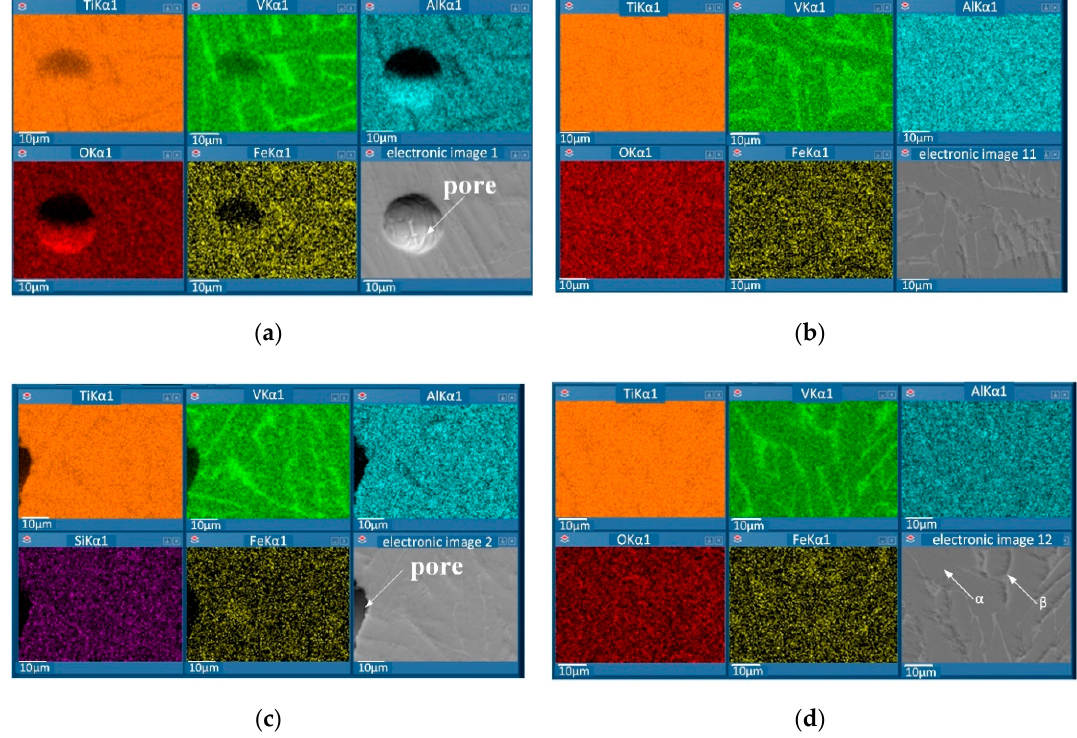
Figure 9. Energy-dispersive X-ray spectroscopy (EDS) mapping of the Ti-6Al-4V alloy samples: ( a ) Sample no. 1, the “parallel” technique; ( b ) sample no. 1, the “parallel” technique without pores; ( c ) sample no. 2, the “perpendicular” technique at times; ( d ) sample no. 2, the “perpendicular” technique without pores.